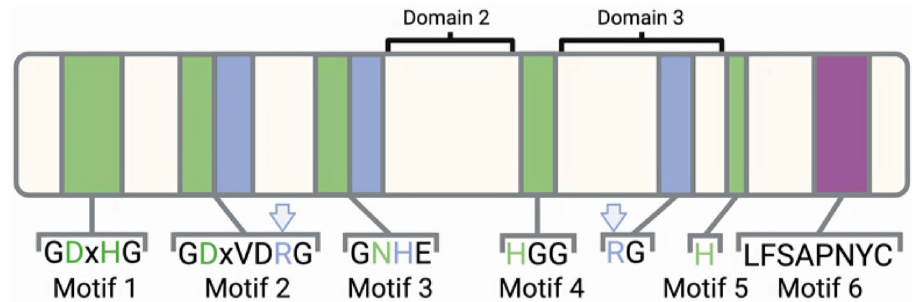
Figure 1. Conserved motifs and domains of the phosphoprotein phosphatases (PPP) of Eukaryotes. Shown is the representative motifs from human PP1α and location of domains 2 and 3. Metal binding residues are shown in green, while residues involved in catalysis (H) and the substrate interacting arginines (R) of the 2-Arginine Clamp are in blue and marked with arrows. Image was created using BioRender